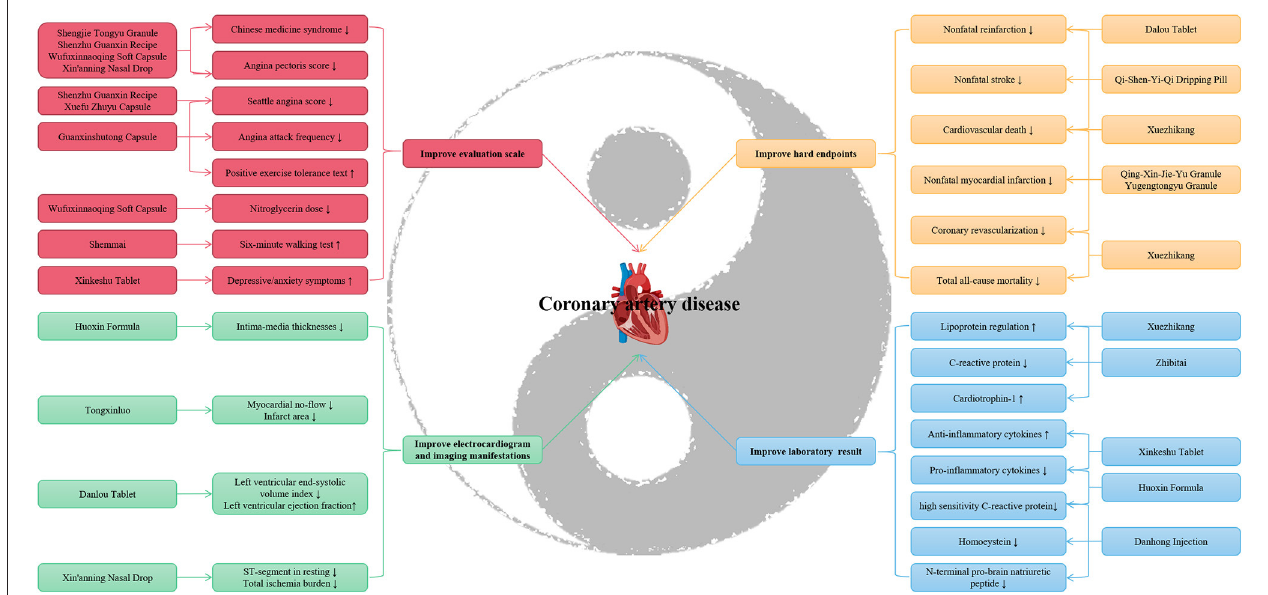
FIGURE 1 | Traditional Chinese medicine in coronary artery disease